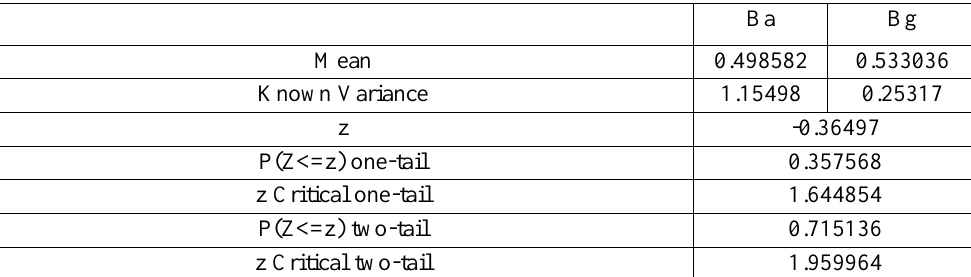
Table 3. z Test: Two Sample for